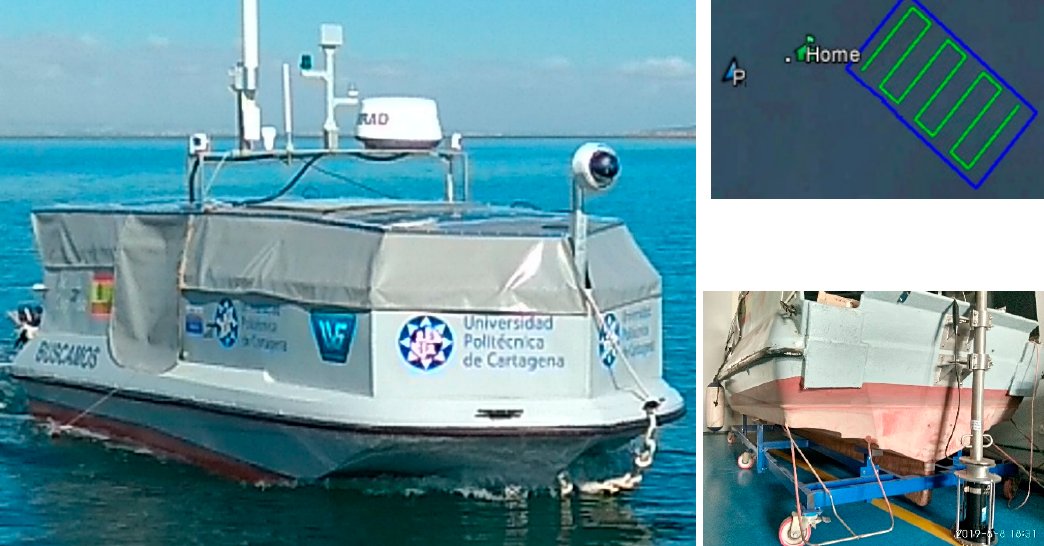
Figure 3. ASV with SBP (parametric sub-bottom profiler) ( left ), coupling of support to the boat ( bottom right ), ASV course definition ( top right ).